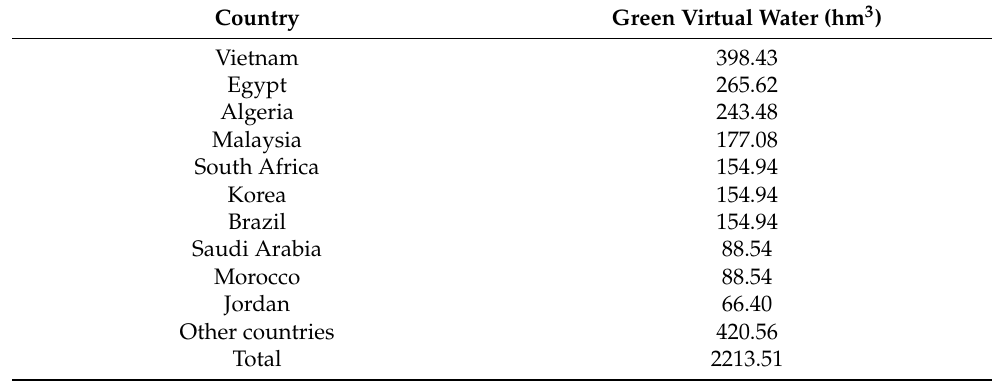
Table 3. Green virtual water of the province of Buenos Aires related to maize grain imported by the main trading countries in 2016–2017.